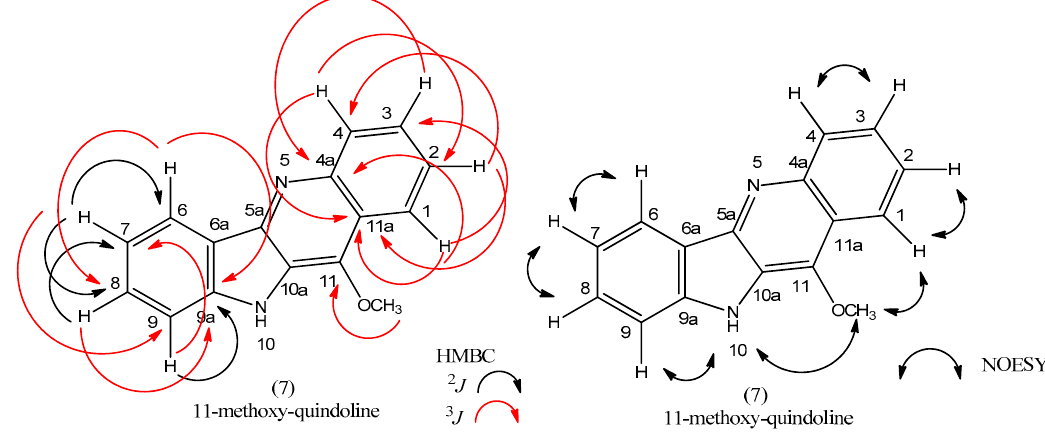
Figure 4. HMBC and NOESY correlations for compound 7 .